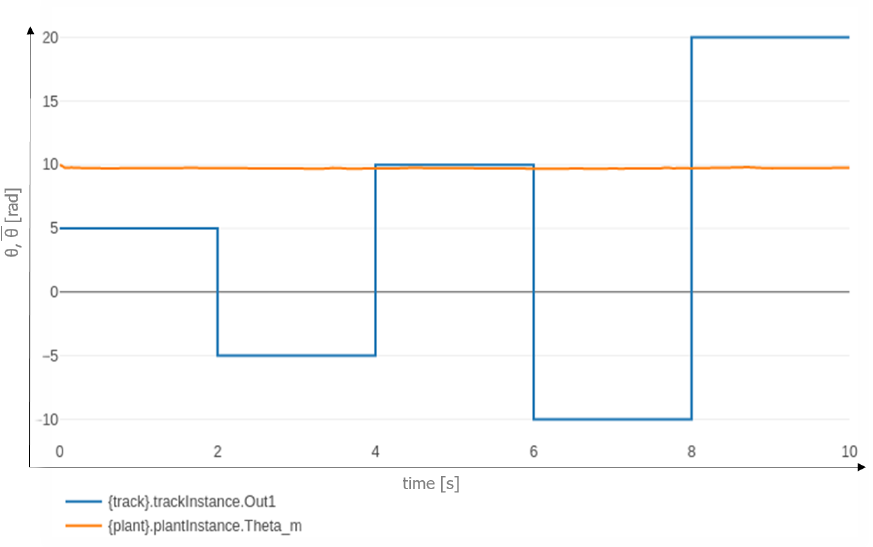
Figure 11. Co-simulation for K 11 = − 1000 and K 22 = − 500.